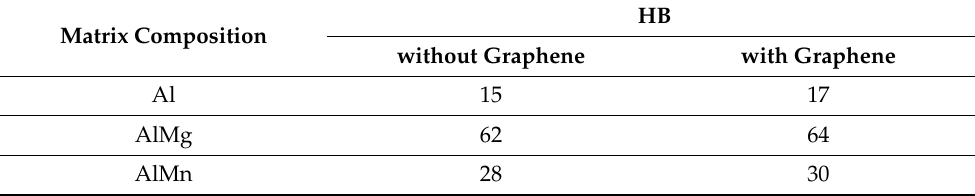
Table 1. Hardness of the